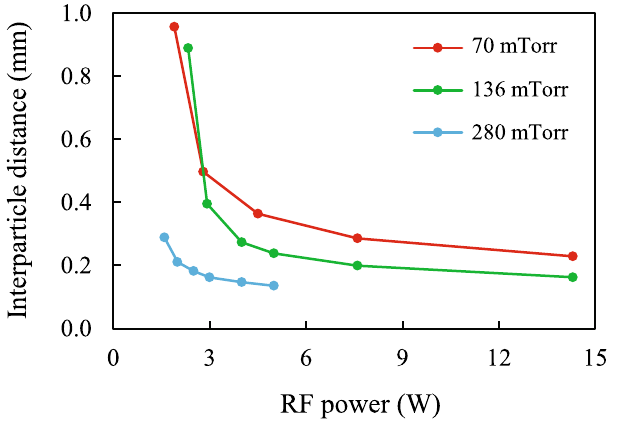
Figure 2. Dependence of the mean interparticle distance (cid:31) on the RF power at the gas pressures shown.